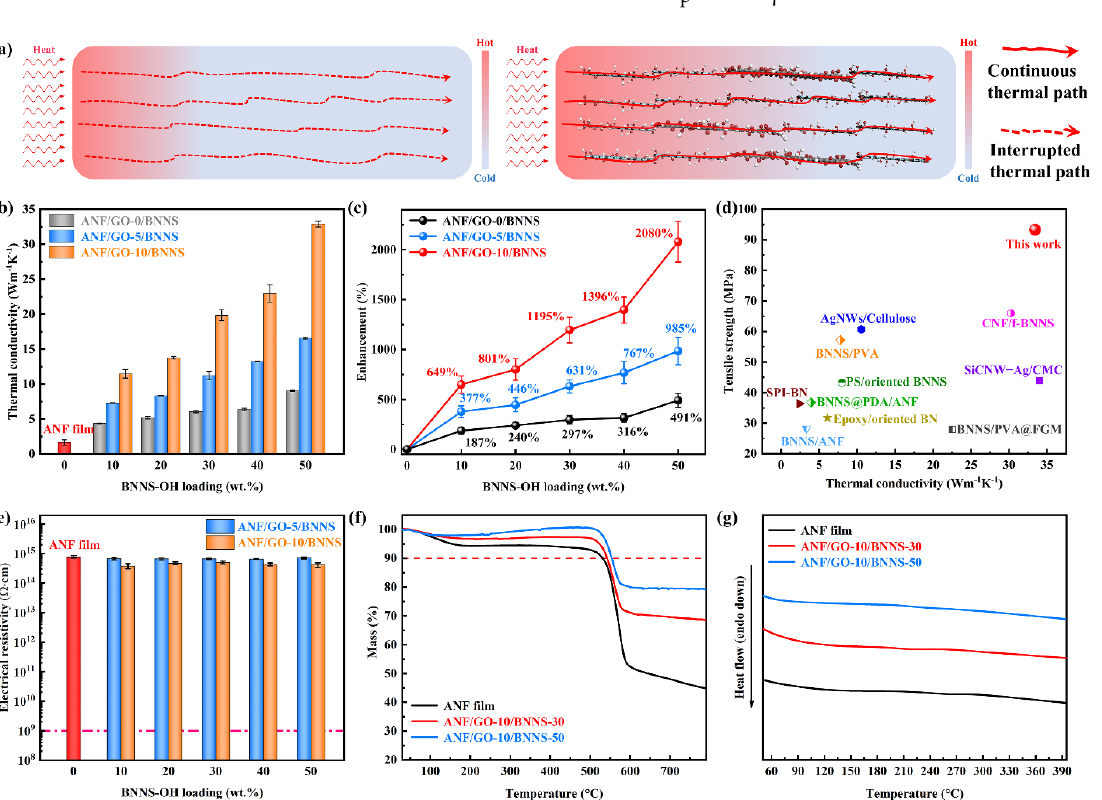
Figure 5. ( a ) Schematic showing potential thermal conduction mechanisms within the ANF film and ANF/GO/BNNS composite film. ( b ) In-plane thermal conductivity and ( c ) thermal conductivity enhancement of the composite films as a function of contents of GO and contents of BNNS-OH. ( d ) Comparison of thermal conductivity and tensile strength between the ANF/GO/BNNS composite film with other composites films reported in the literature. ( e ) Volume resistivity, ( f ) TGA curves, and ( g ) DSC curves of ANF film, ANF/GO-10/BNNS-30, and ANF/GO-10/BNNS-50 composite films. Table 1. Comparison of in-plane thermal conductivity and tensile strength of ANF/GO/BNNS composite film with other composite films reported in the literature.